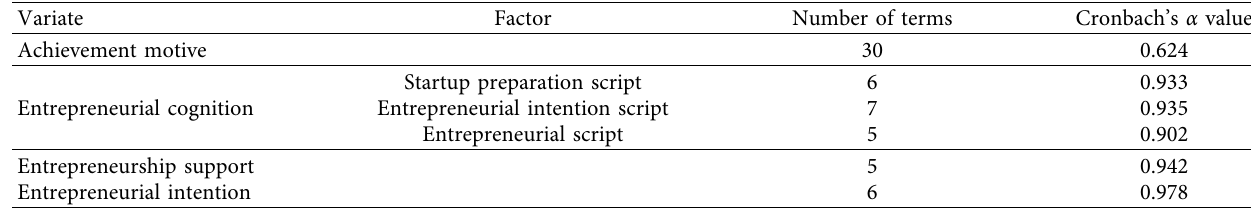
Table 4: Reliability test